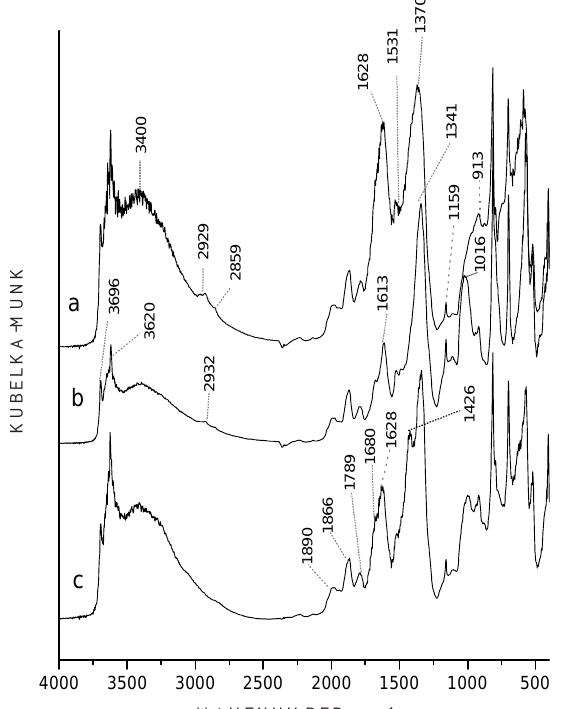
Figure 1. DRIFT spectra of the whole soil (a), of the HS-extracted soil (b) and of the oxidized soil (c) of the